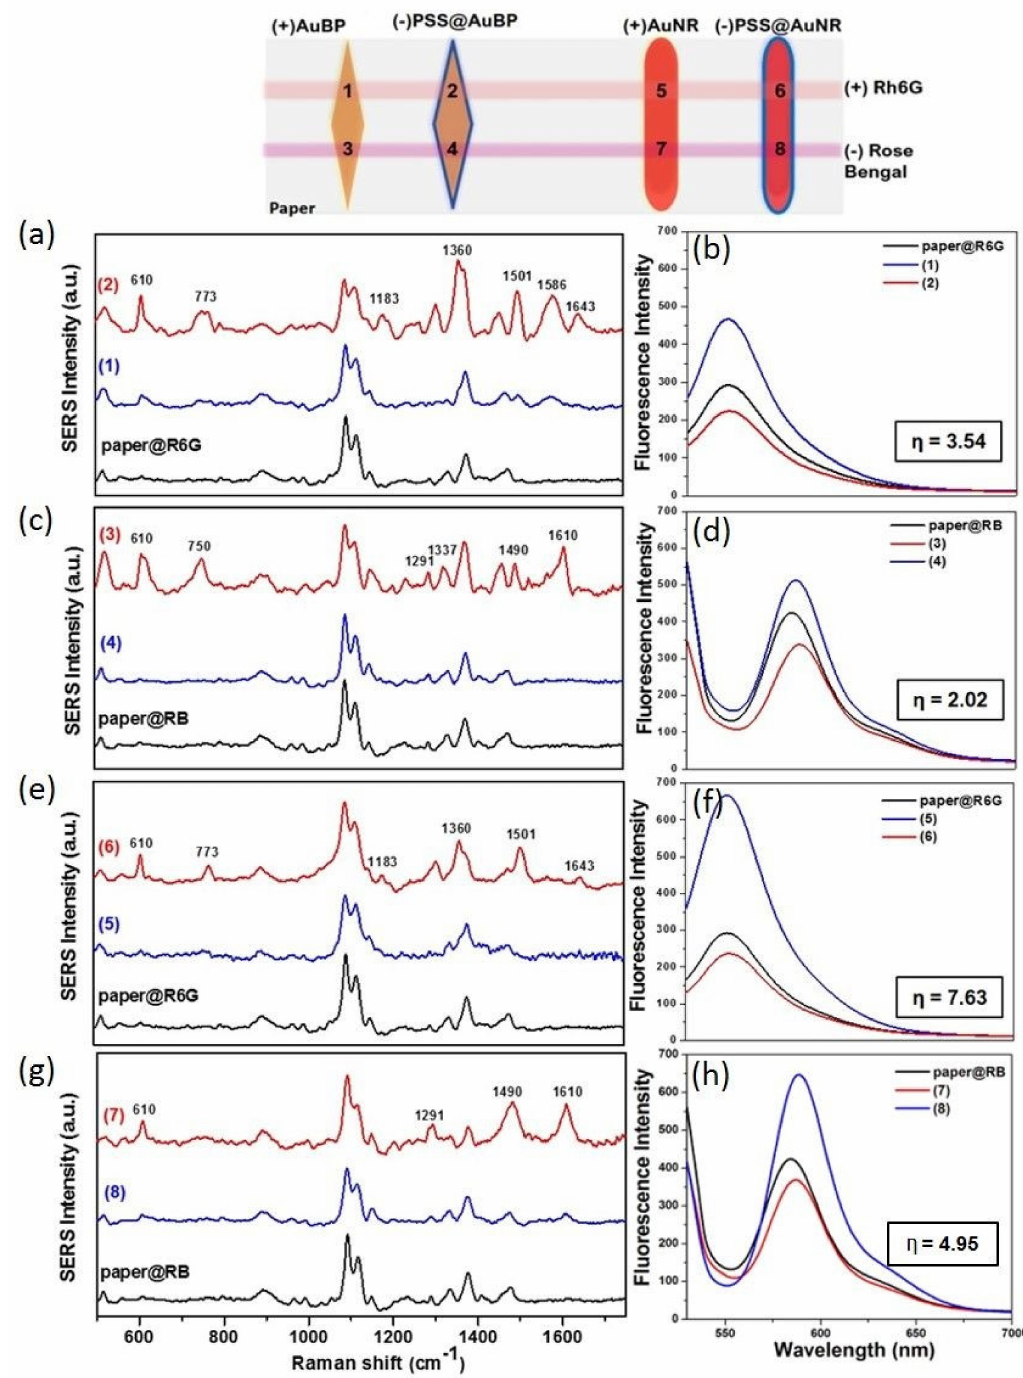
Figure 3. Validation of the “On / O ff Switch" (nano)sensor illustrated on the top by complementary recording SERS detection ( a , c , e , g -left panel) and MEF detection ( b , d , f , h -right panel) spectra collected from the numbers (1–8) marked on the illustrative scheme compared to free calligraphed R6G (10 − 4 M) and RB (10 − 4 M) analyte onto the bare Whatman paper (black spectra) (i.e. near plasmonic